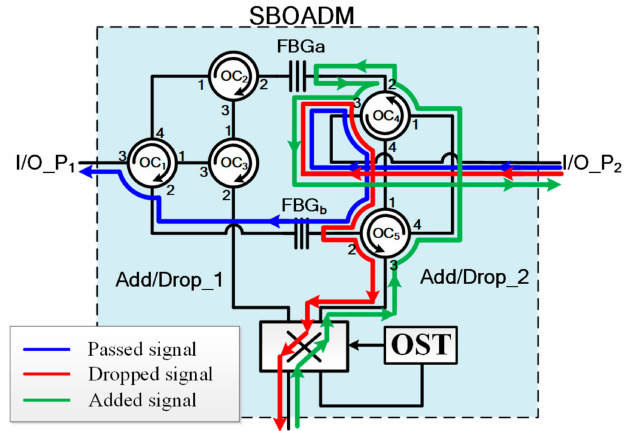
Figure 2. Structure of a single-line bidirectional optical add / drop multiplexer (SBOADM; the optical signals are fed from the right-hand